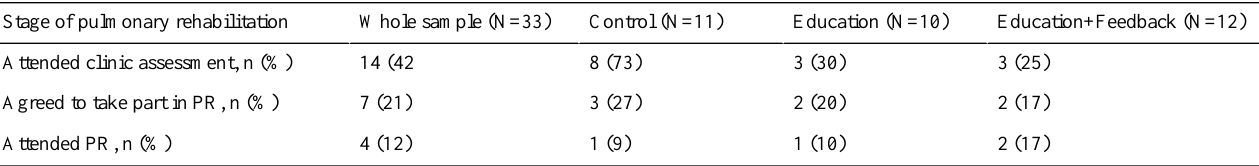
Table 2. Uptake to pulmonary rehabilitation (PR) stratified by study